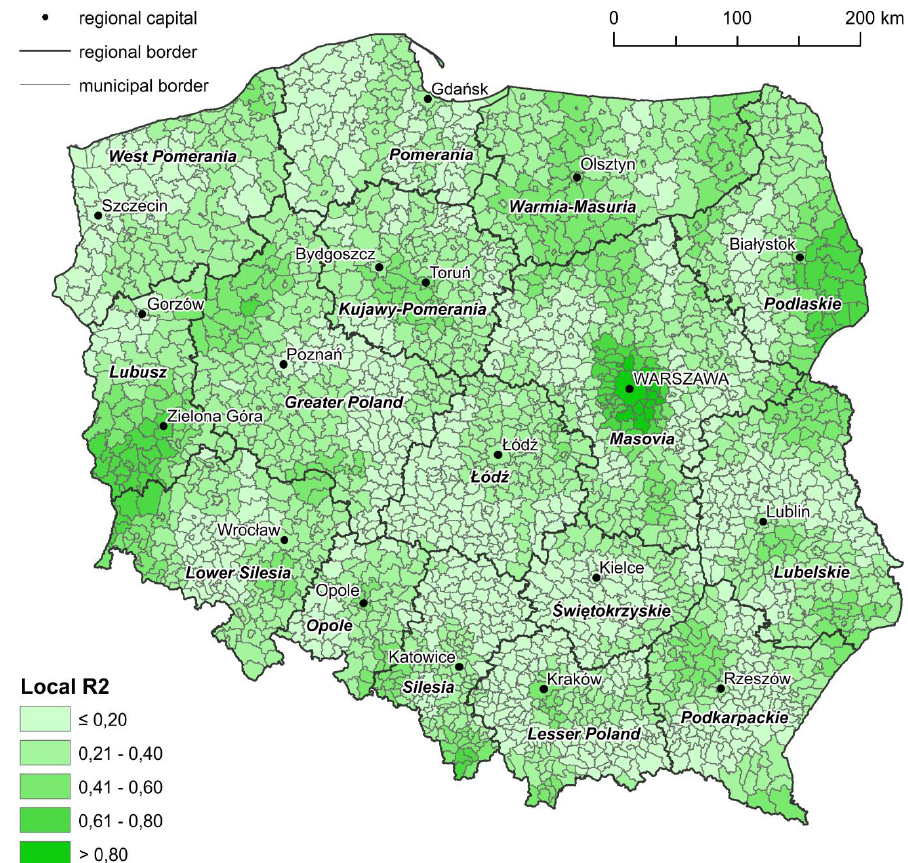
Figure 4. Coefficients of determination of local models estimating land cover changes in Poland, in the years 2012–2018.